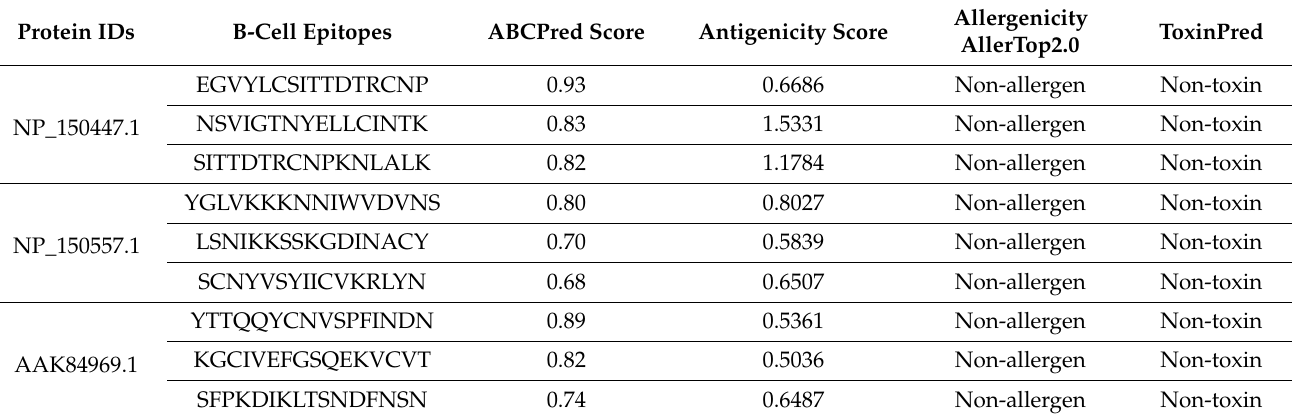
Table 2. The prioritized B-cell epitopes and their immunogenic